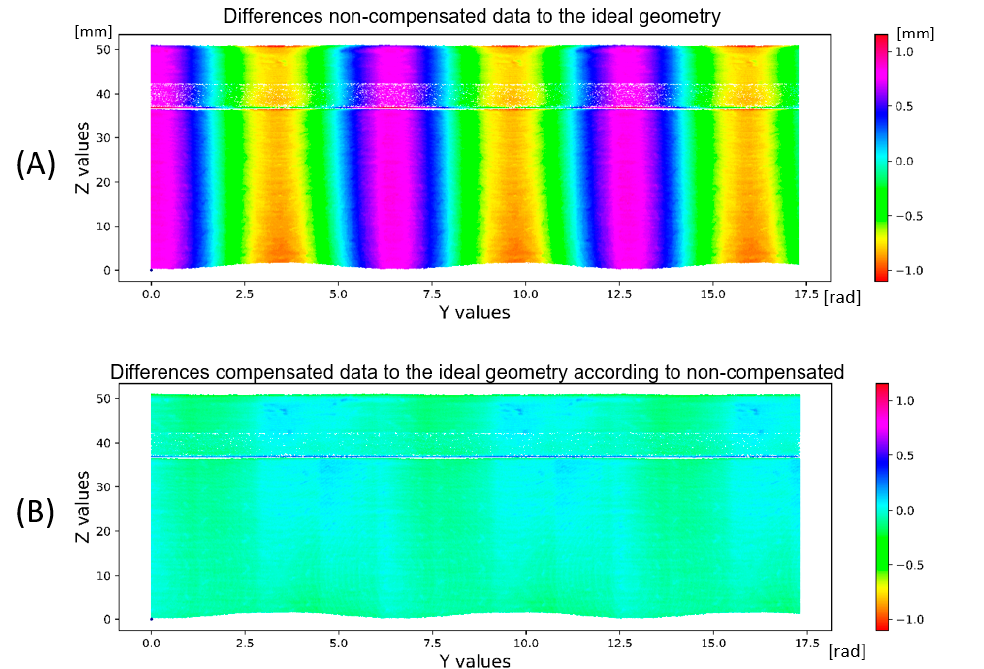
Figure 16. Impact of the first harmonic component in data: ( A )—including the first harmonic component, and ( B )—with the first harmonic component in data removed.